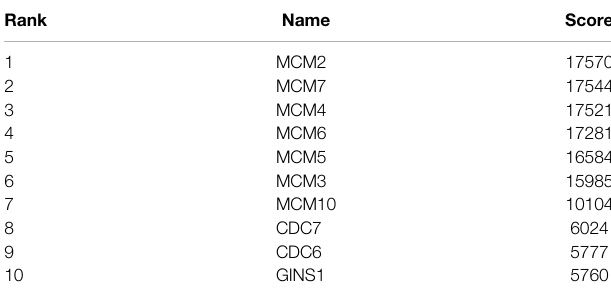
TABLE 1 | The top ten genes ranked as hub genes by the MCC algorithm.